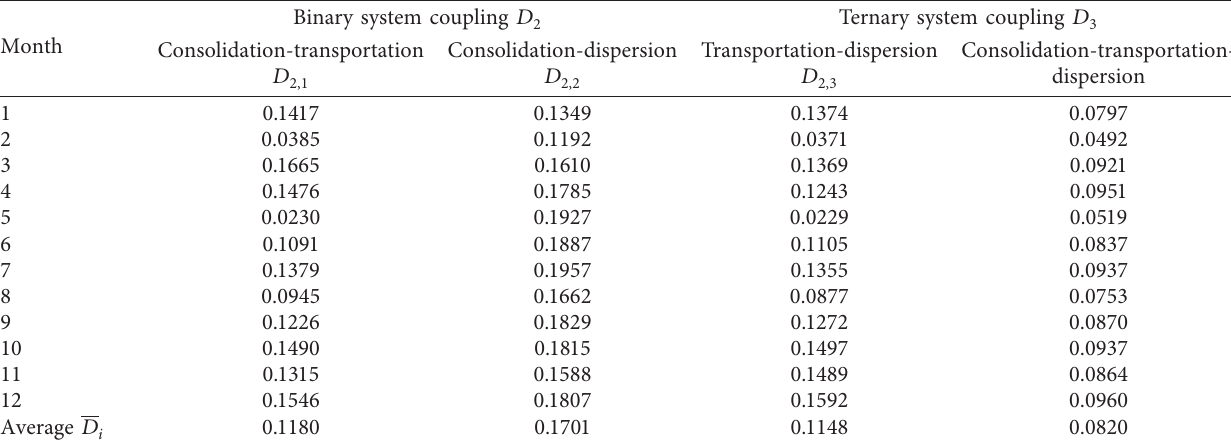
i of the collection and distribution system of Tongchuan Depot in 2017.